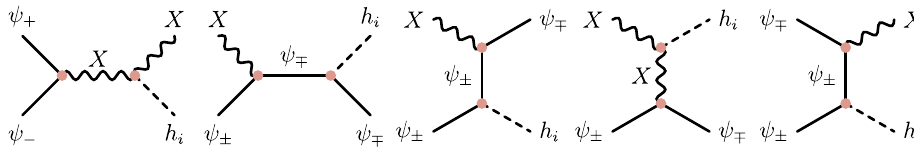
Fig. 3 The vector dark matter X μ and Majorana fermion dark matter ψ ± annihilation diagrams. Above V and ( ¯ f ) f denote the SM vector bosons ( W ± and Z ) and the SM (anti)fermions (quarks and leptons)